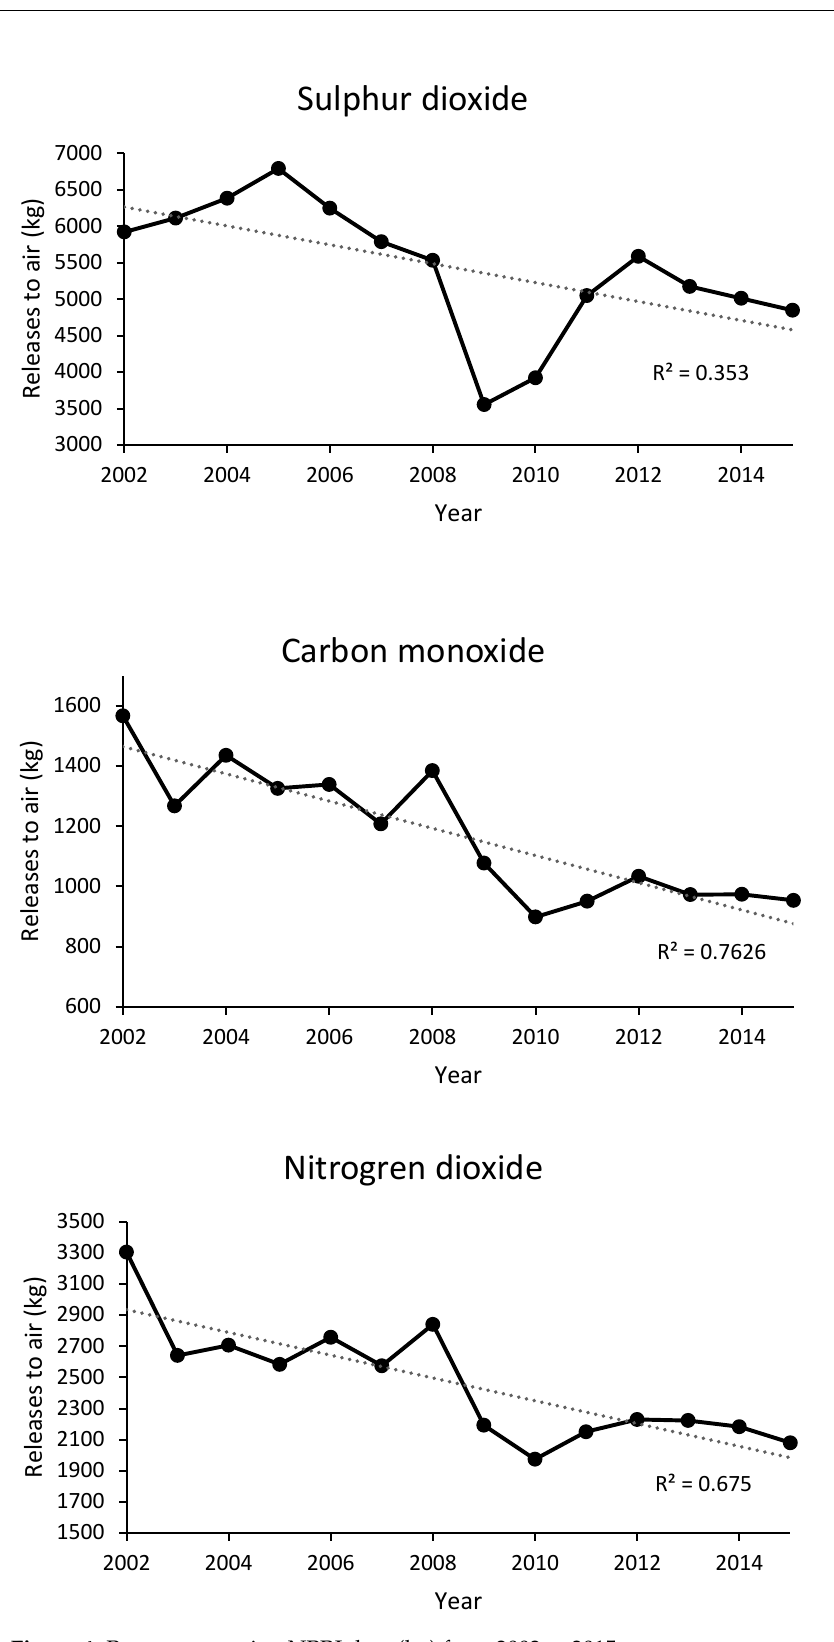
Figure 4. Power generation NPRI data (kg) from 2002 to 2015.